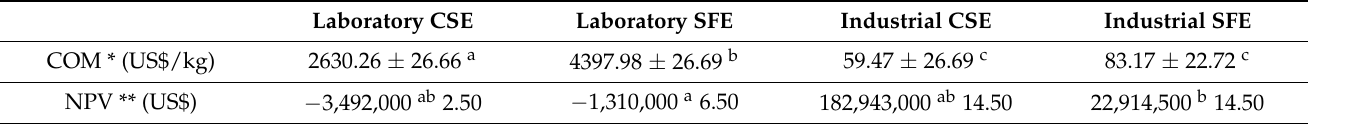
Table 6. Statistical analysis of the significance of the cost of manufacturing (COM) and net present value